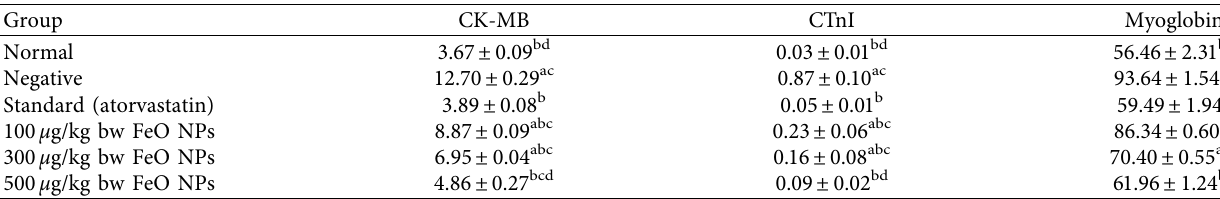
Table 5: Effect of iron oxide nanoparticles on serum cardiovascular markers in